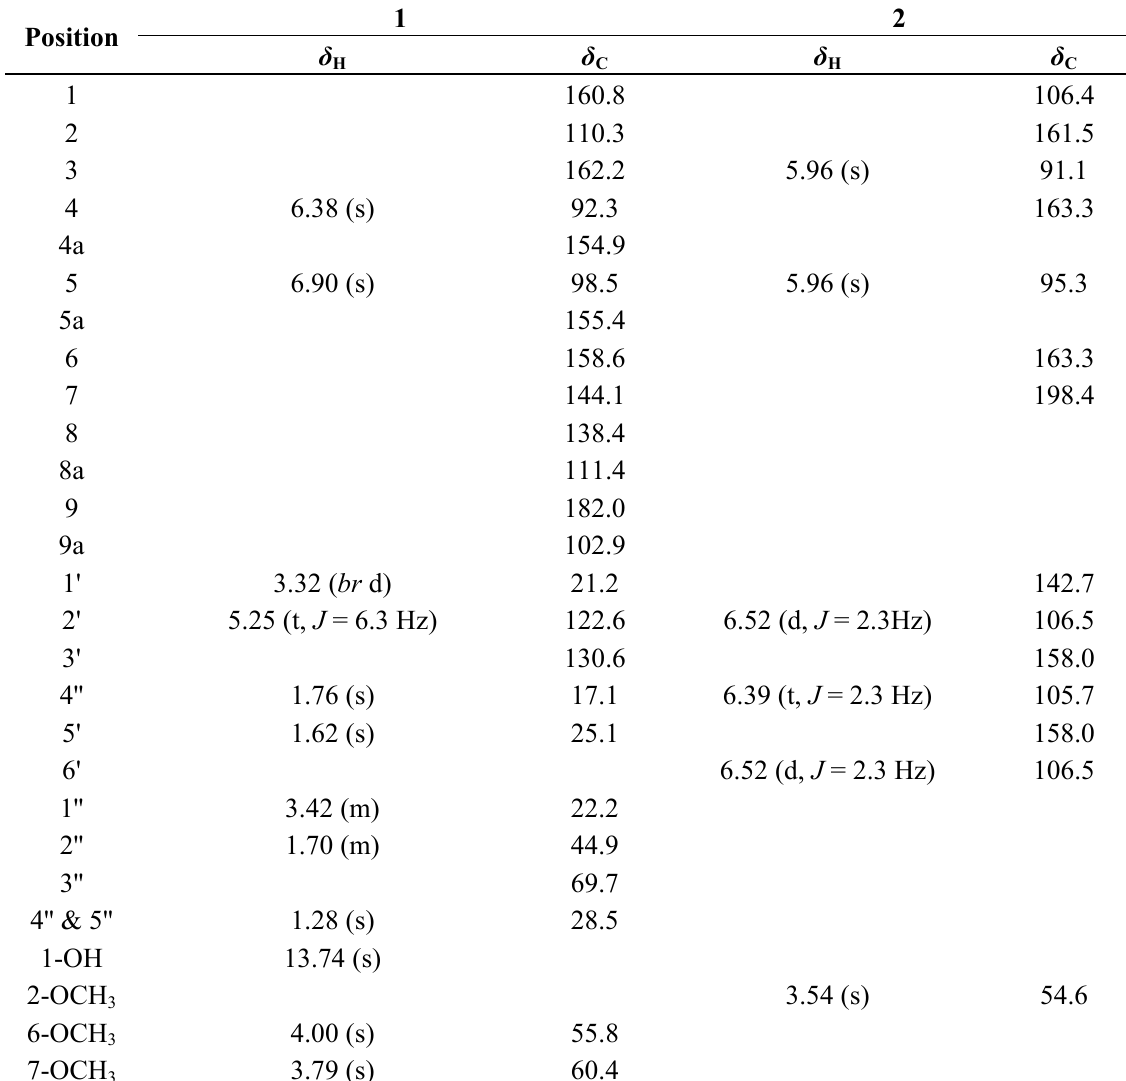
Table 1. 1 H-NMR (500 MHz) and 13 C-NMR (125 MHz) spectroscopic data for compound 1 (in Me CO- d ) and 2 (in CD 2 6 3